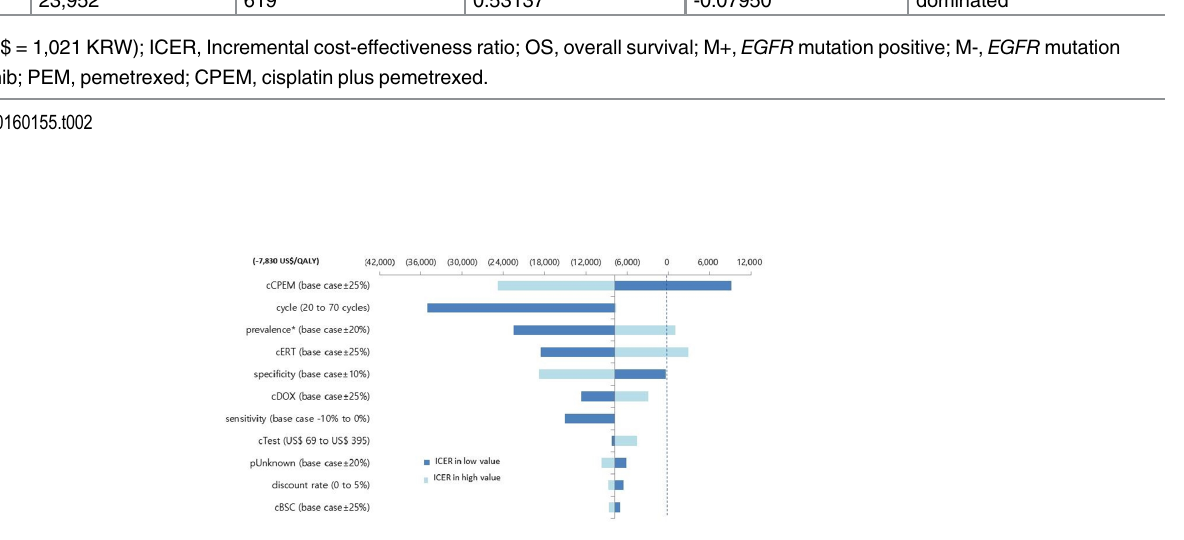
Fig 2. Tornado diagram of one-way sensitivity analysis. * Prevalence of EGFR mutation. cERT, medical cost of erlotinib; cCPEM, medical cost of cisplatin plus pemetrexed; cDOX, medical cost of docetaxel; cTest, cost of genetic test; cBSC, medical cost of best supportive care in terminal cancer patients; pUnknown, proportion of unknown tests.